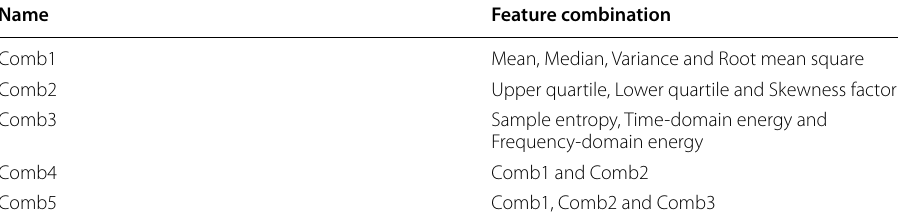
Table 2 Meanings of the feature